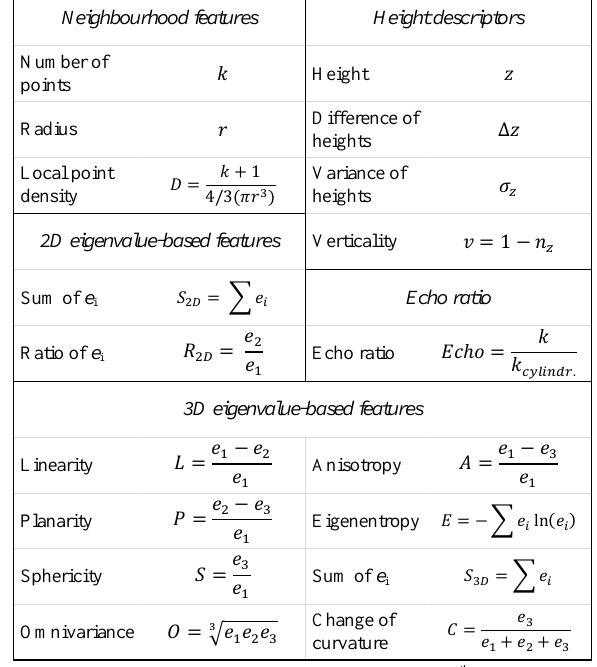
Table 1. 18 values of a feature vector; e i is the i th eigenvalue (downwardly ordered) and n z is the third component of the normal vector n